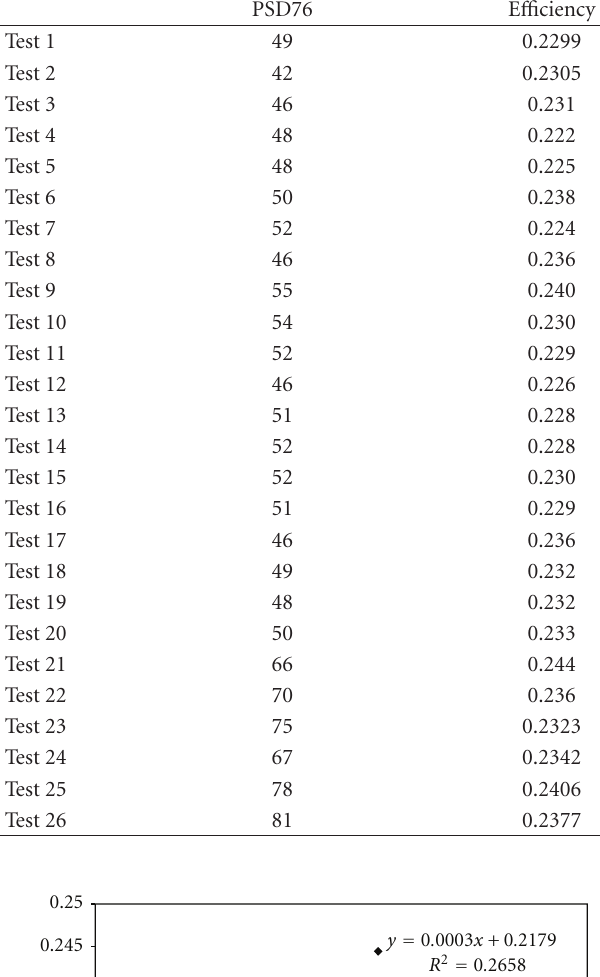
Table 6: Coal flow rate and MW generated.